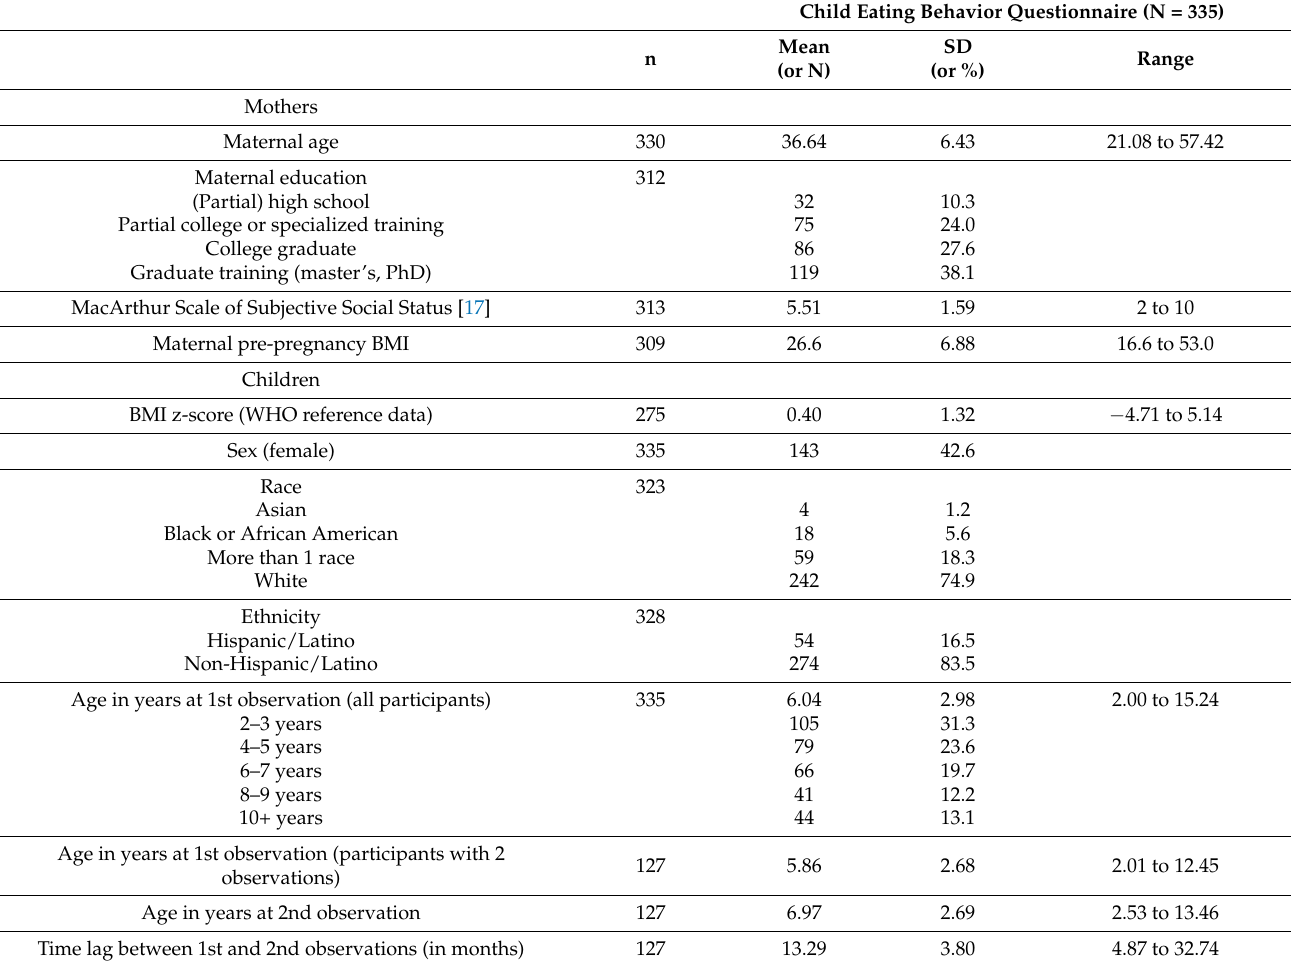
Table 1. Sample characteristics of participants completing the Child Eating Behavior